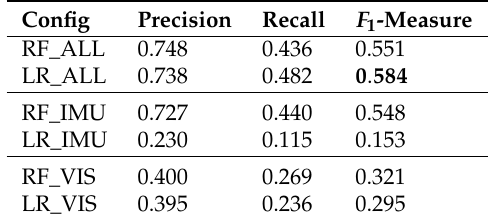
Table 4. Results for CMU-MMAC dataset. Here we used the same method as above to evaluate our method. As we do not have bounding-box ground truth data, we can only learn on the output of our neural